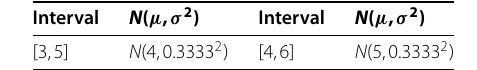
Table 1 Normal distributions corresponding to interval coefficients in the first constraint of Example 1